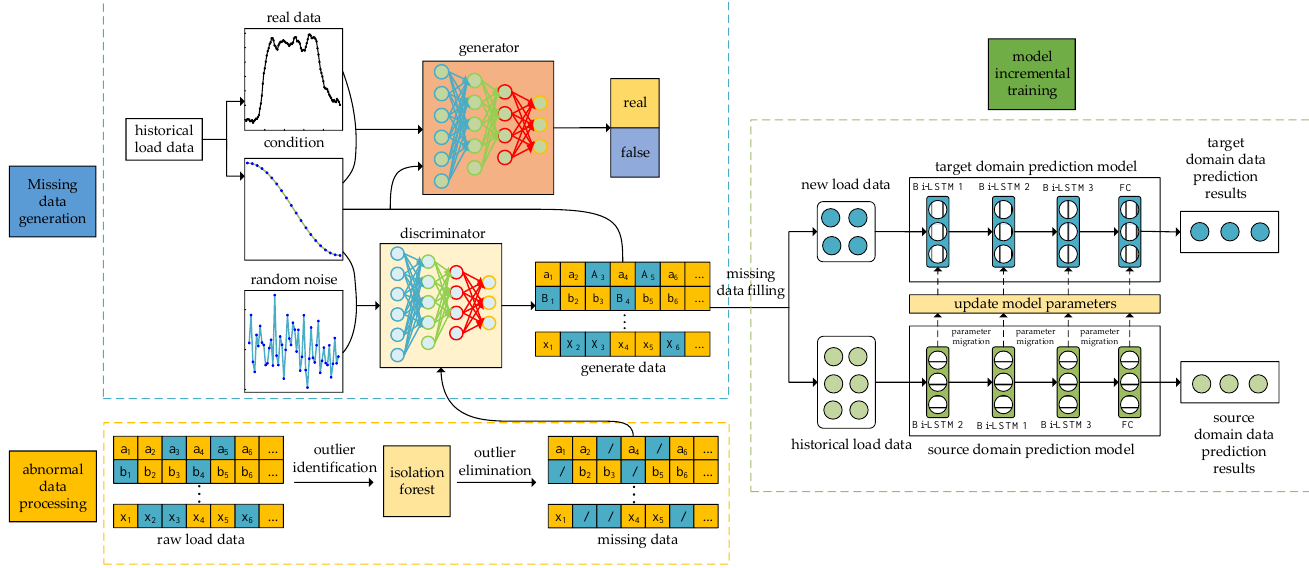
Figure 8. Ultra-short-term load dynamic forecasting framework considering abnormal data recon- struction based on model incremental training.